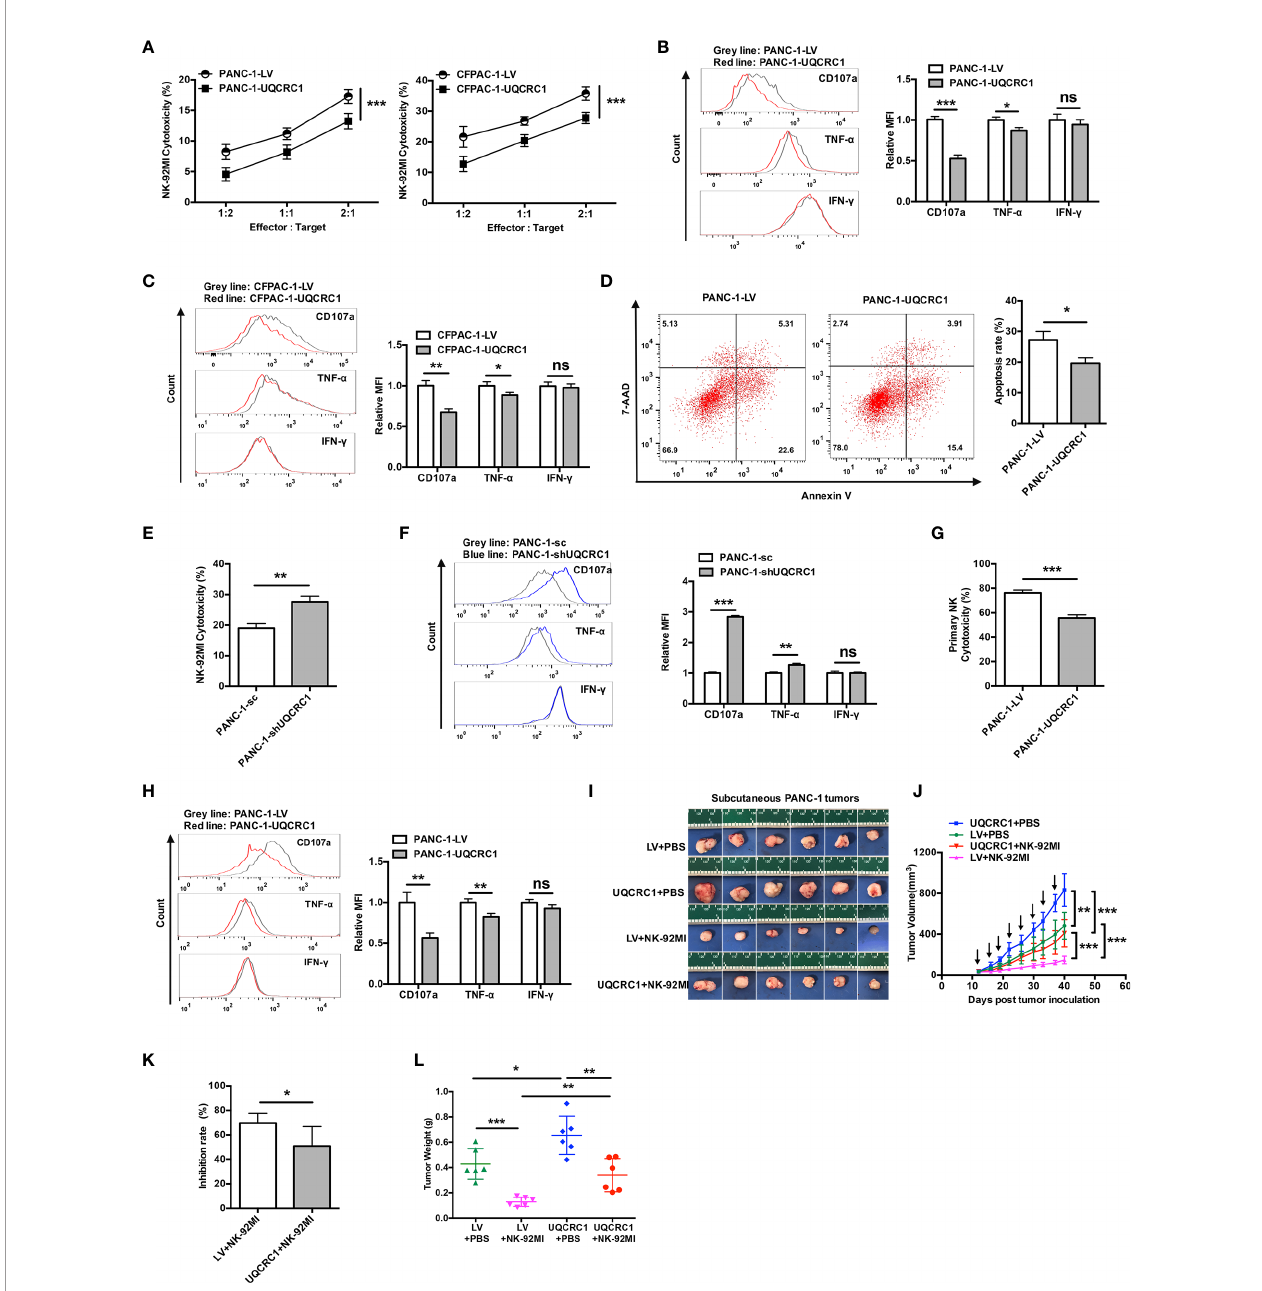
FIGURE 1 | UQCRC1 expressed in cancer cells inhibits the cytotoxicity of NK cells against PC. (A) Cytotoxicity of NK-92MI cells against UQCRC1-overexpressing or control PC cells (PANC-1 or CFPAC-1). The effector cells were co-cultured for 6 h with target cells at an effector: target (E: T) ratios of 2:1, 1:1, and 1:2. (B) Representative fl ow cytometry plots and quanti fi cation of CD107a, TNF- a , and IFN- g expression in NK-92MI cells after co-culture with UQCRC1-overexpressing (red) or control (grey) PANC-1 and (C) CFPAC-1 cells at a ratio of 1:1 for 6 h. (D) Representative fl ow cytometry plots and quanti fi cation of NK cell-induced tumor cell apoptosis rates of tumor cells in the UQCRC1-overexpressing or control tumor spheroids after co-culture for 24 h. (E) Cytotoxicity of NK-92MI cells against UQCRC1-knockdown or control PANC-1 cells at an E: T ratio of 2:1. (F) Representative fl ow cytometry plots and quanti fi cation of CD107a, TNF- a , and IFN- g expression in NK-92MI cells after co-culture with UQCRC1-knockdown (blue) or the control (grey) PANC-1 cells. (G) Cytotoxicity of primary NK cells against UQCRC1-overexpressing or control PANC-1 cells at an E: T ratio of 5:1. (H) Representative fl ow cytometry plots and quanti fi cation of CD107a, TNF- a , and IFN- g expression in primary NK cells after co-culture with UQCRC1-overexpressing (red) or the control (grey) PANC-1 cells at a ratio of 1:1 for 6 h. (I – L) The subcutaneous xenografts, tumor growth curves, tumor inhibition rate, and the tumor weights in NPSG mice inoculated with UQCRC1-overexpressing or control PANC-1 cells for 40 days (n = 6). Black arrows indicate the day on which mice accepted PBS or NK cell therapy. All data are presented as the mean ± SD (n = 3 independent biological replicates unless otherwise indicated). *, p < 0.05; **, p < 0.01; ***, p < 0.001; ns, not signi fi